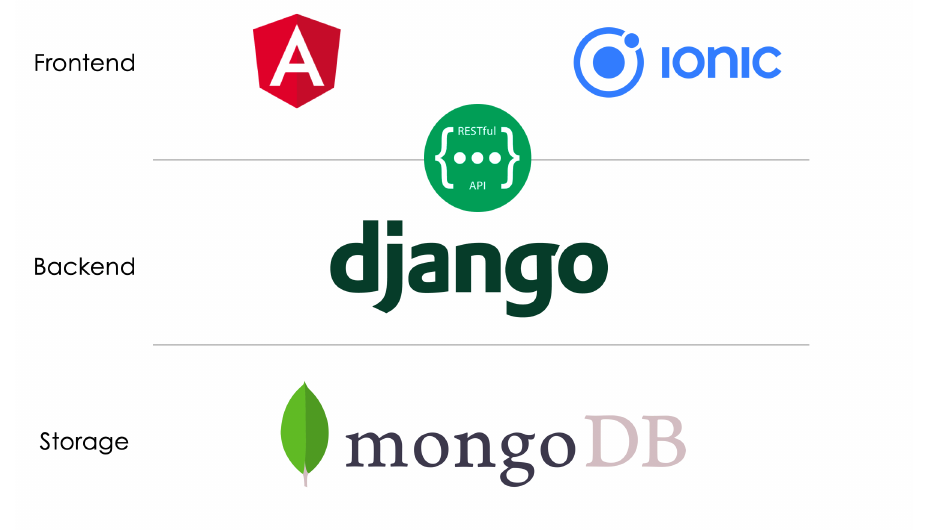
Figure 4. GigAdvisor : the 3-layer